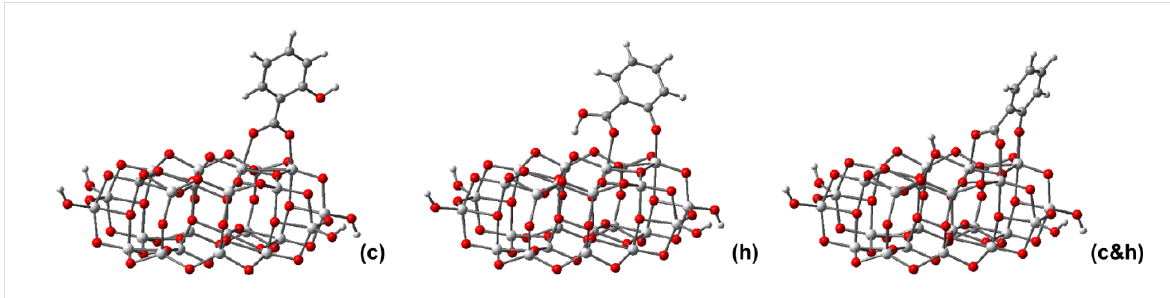
Figure 6: Optimized geometry of SA adsorbed on titania, calculated at DFT/B3LYP/3-21G* level.